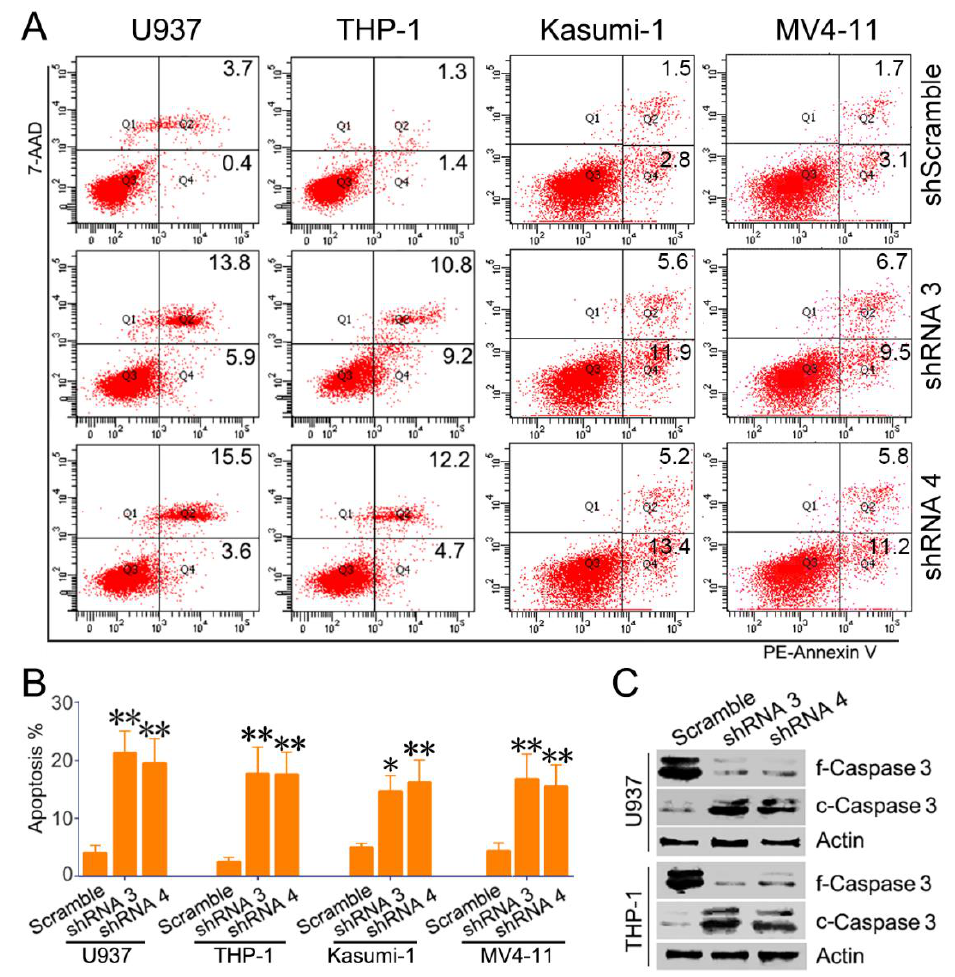
Figure 5. Knockdown of SH3BP5 expression-induced apoptosis of AML cells. ( A ) U937, THP-1, Kasumi-1, and MV4-11 cells were infected with SH3BP5 or scramble shRNAs for 72 h, followed by analysis of cell apoptosis by 7-AAD and PE-Annexin V labeling. Shown are representative scatter plots of flow cytometry. ( B ) Shown is apoptosis rate of U937, THP-1, Kasumi-1, and MV4-11 cells. N = 3, *, p < 0.05 **, and p < 0.01 compared with the scramble shRNA group. ( C ) U937 and THP-1 cells were infected with SH3BP5 or scramble shRNAs for 72 h, followed by western blotting analysis of expression of Caspase 3 (f-Caspase 3, full-length Caspase 3; c-Caspase 3, cleaved-Caspase 3).